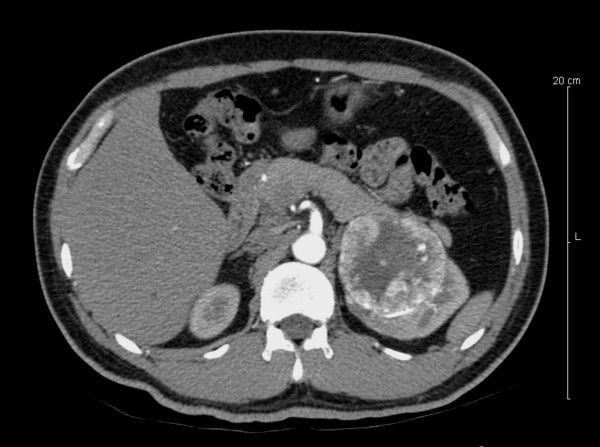
CT scan showing the renal mass.